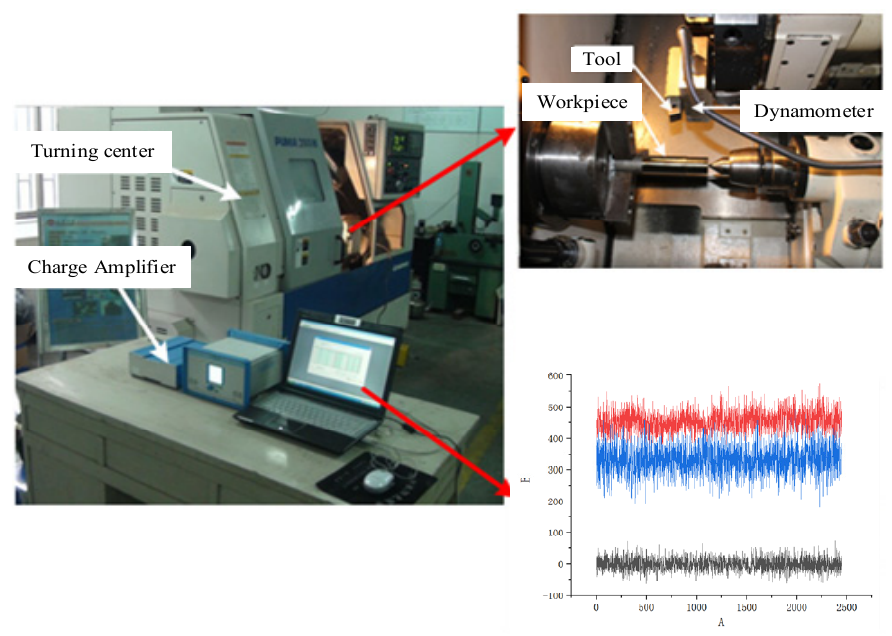
Figure 2. Set-up of machining experiments and test devices.